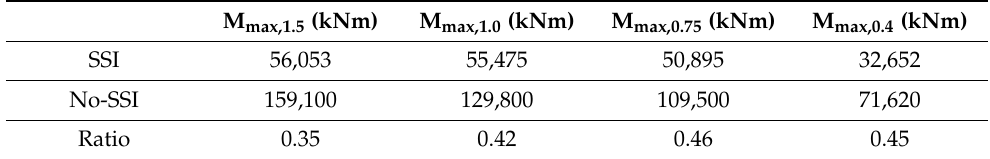
Figure 10. Comparison between the moment time-histories at the base of the pier obtained by the two models, considering or neglecting the SSI, for the seismic input n. 1 (F a = 1.5). Table 5. Maximum moments computed by including vs. neglecting SSI, for the four seismic